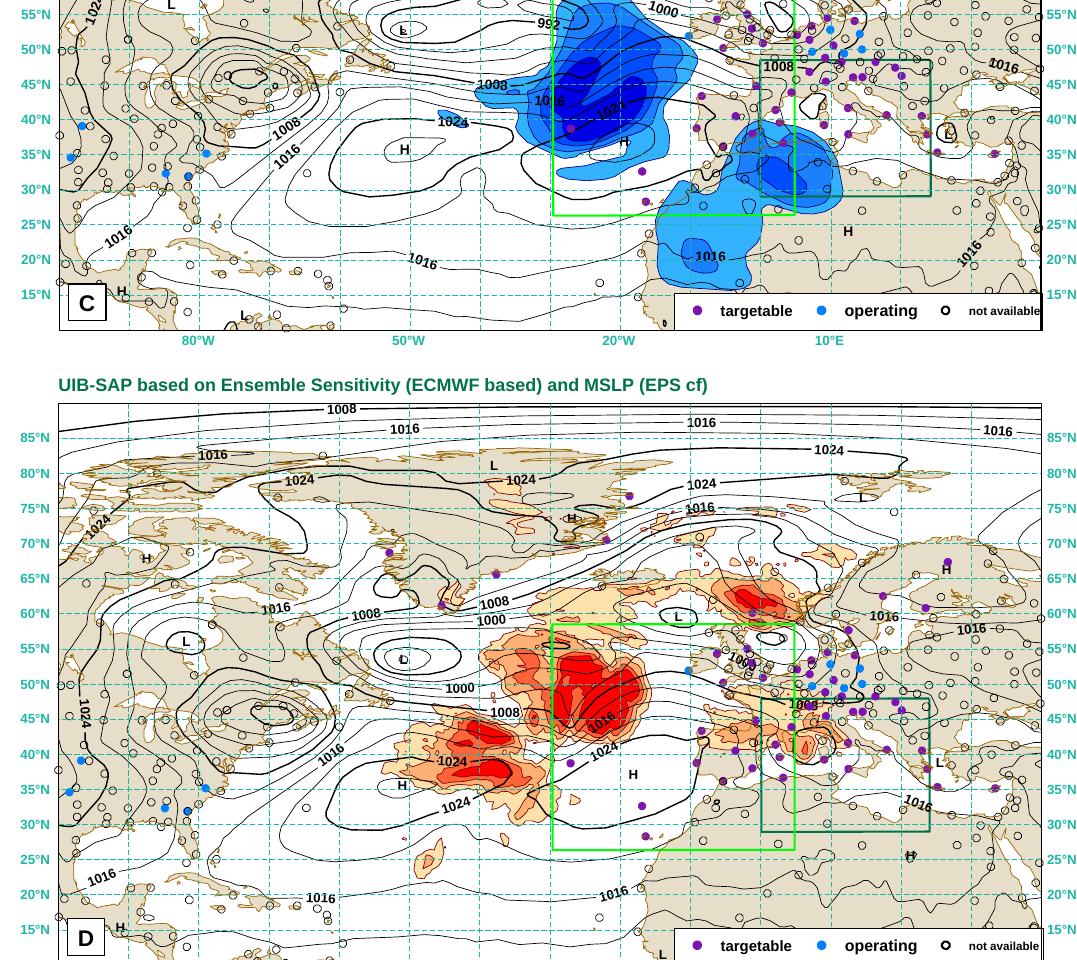
Fig. 2b. Frame C (Upper) is the M´et´eo-France KFS based FTG. This field was available in real time at M´et´eo-France operation centre during the DTS MEDEX-2009. The MSLP is the ARPEGE deterministic operational forecast. Frame D (Lower) is the UIB Ensemble sensitivity based FTG. This FTG has been simulated a posteriori, but reflects exactly what could have been available during the DTS. The ensemble used here is the ECMWF ensemble (EPS) and the MSLP field is the EPS control forecast.